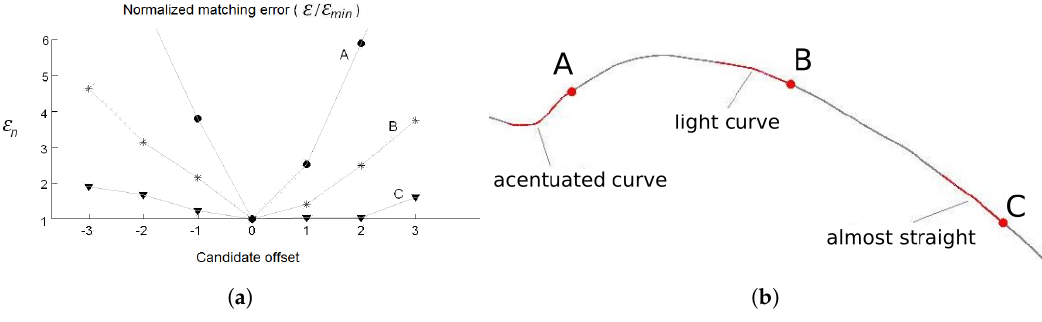
Figure 25. Relation between the BLMR shape and the matching error. ( a ) matching error graph; ( b ) different BLMR shapes.